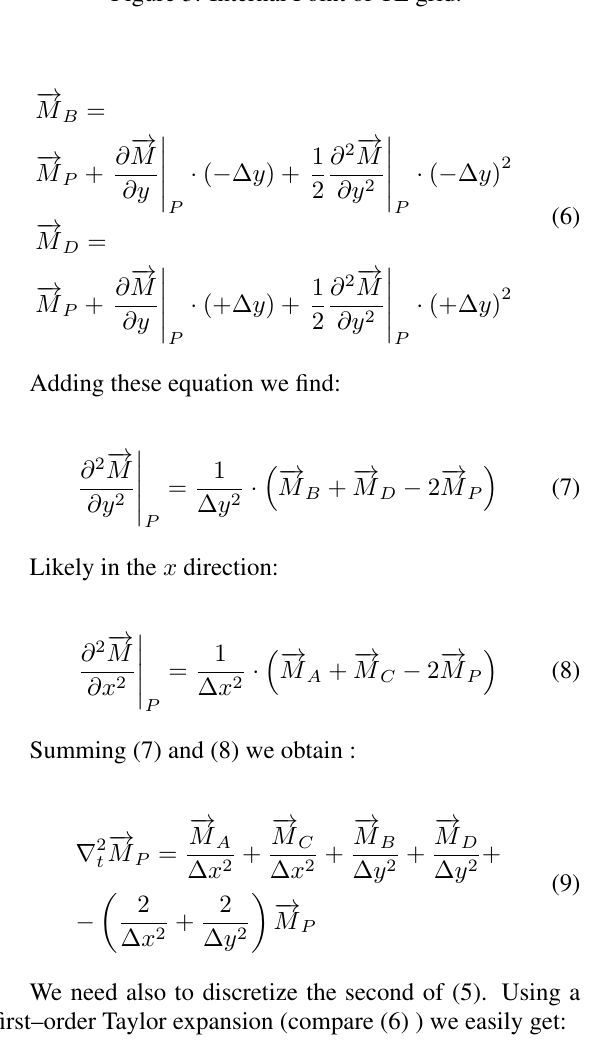
Figure 3: Internal Point of TE